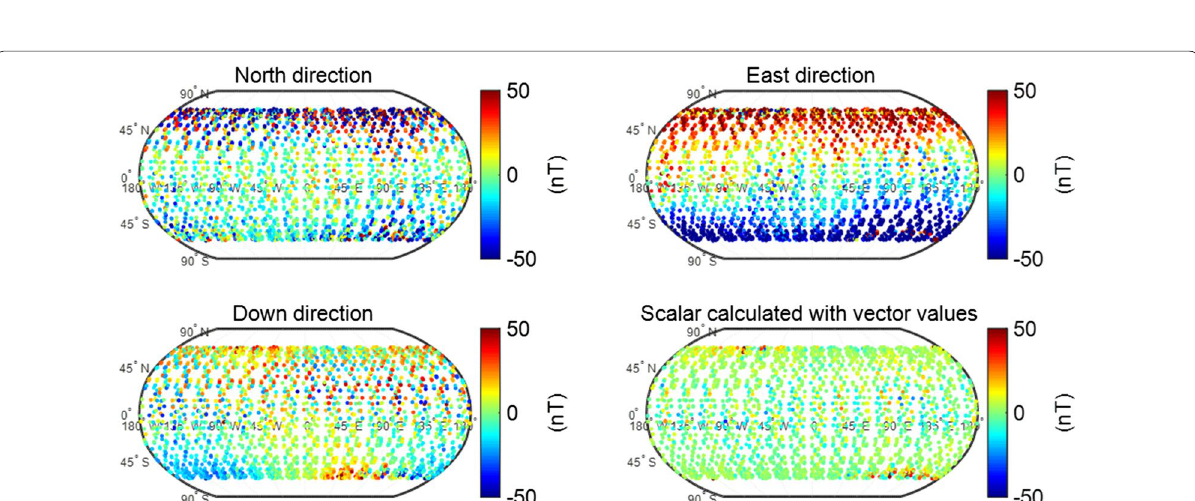
Fig. 21 Comparison of CSES and SWARM B magnetic field data, from August 30 to September 3, 2018